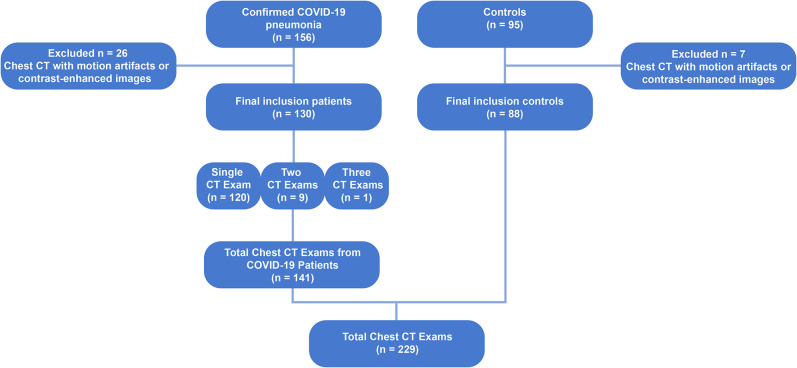
Flow chart diagram showing the patient enrollment and computed tomography selection process. CT, computed tomography; COVID-19, corona virus disease-19; RT-PCR, reverse-transcription polymerase chain reaction.